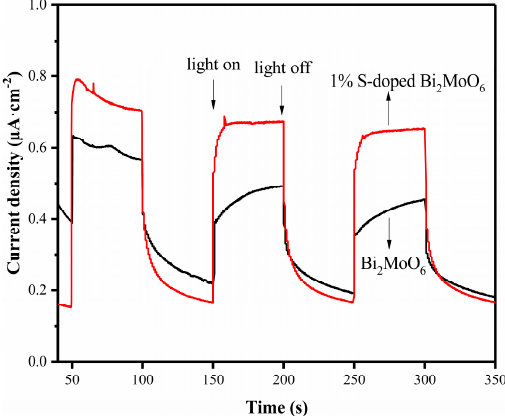
Figure 13. Photocurrent density of Bi 2 MoO 6 and 1% S-doped Bi 2 MoO 6.